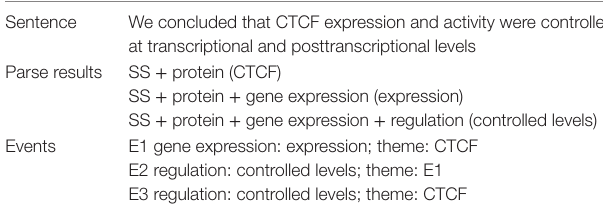
TaBle 7 | An example of the results of semantic parsing for event detection (Zhou and He, 2011).